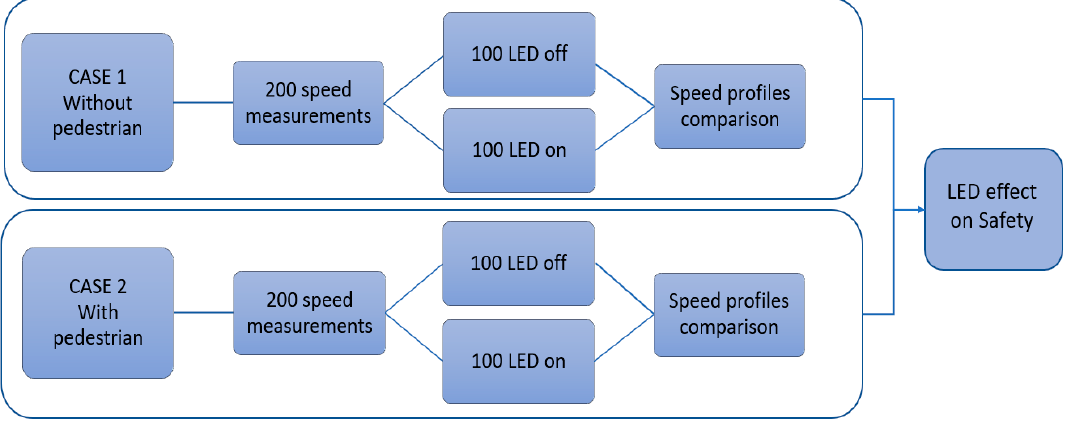
Figure 3. Methodological scheme.